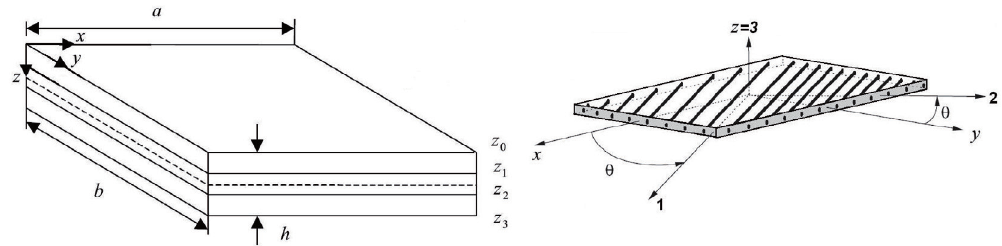
Fig. 2. Laminated composite plate.